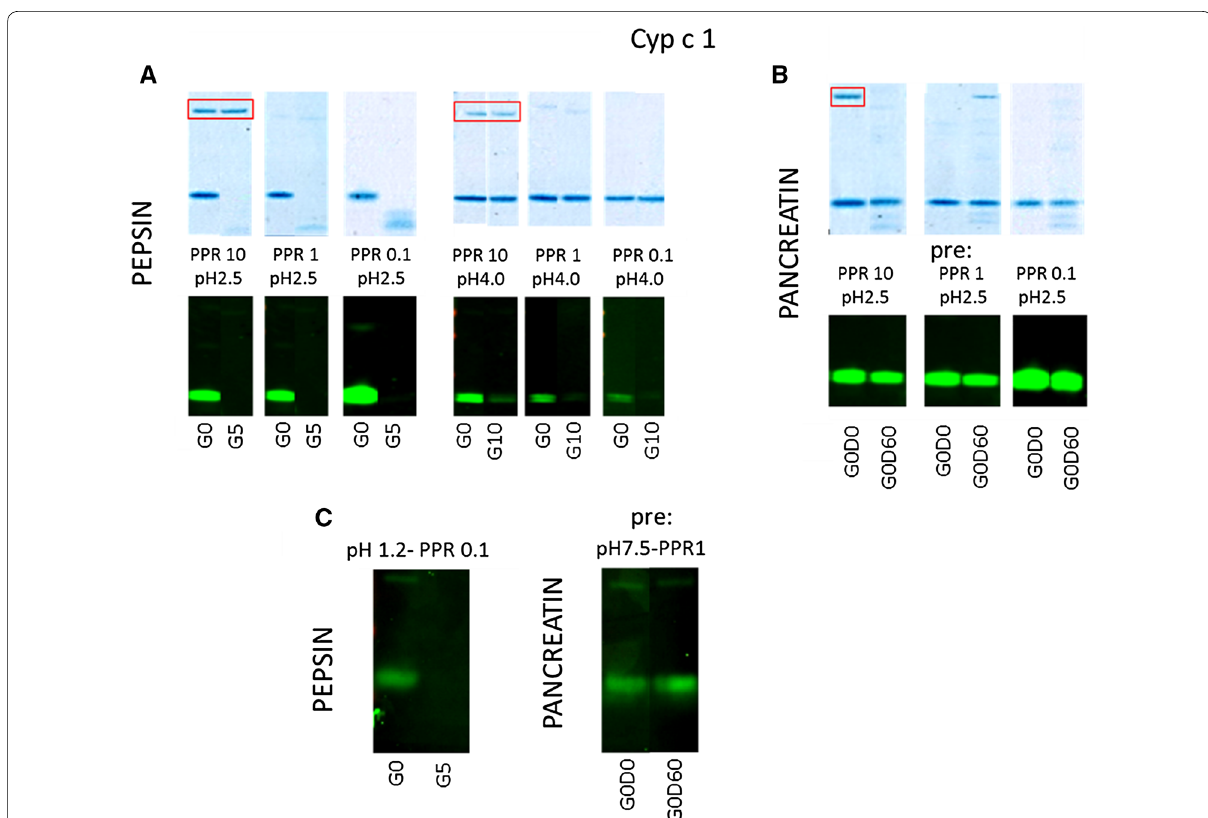
Fig. 6 Selected SDS‑PAGE and immunoblot samples are shown for carp parvalbumin, Cyp c 1. A At pH 2.5 Cyp c 1 is readily digested by pepsin. With decreasing PPR, presence of residual breakdown peptide increases, but these are not recognized on immunoblot. Pepsin band on SDS‑PAGE is boxed in red. B Cyp c 1 is highly resistant to pancreatin with some appearance of similar breakdown peptides as observed upon exposure to pepsin. C IgE immunoblotting confirms pepsin and pancreatin resistance characteristics observed wit rabbit